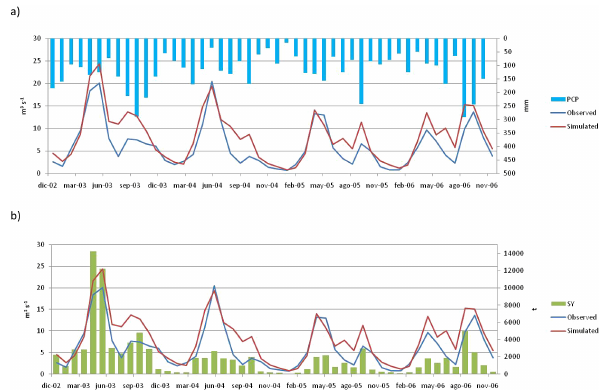
Figure 4. Compared monthly hydrographs simulated by SWAT for the Linsoles reservoir inflow gauge station, with (a) simulated monthly rainfall for the Benasque catchment and (b) simulated monthly sediment yields (SY; t).